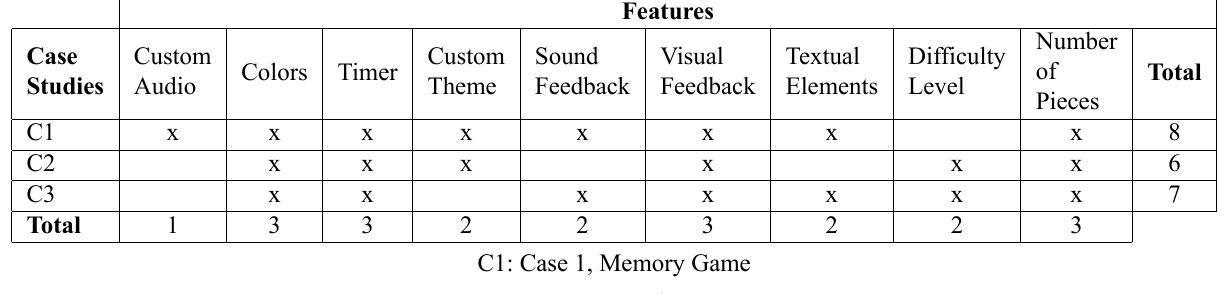
Table 5. Customization features present in developed